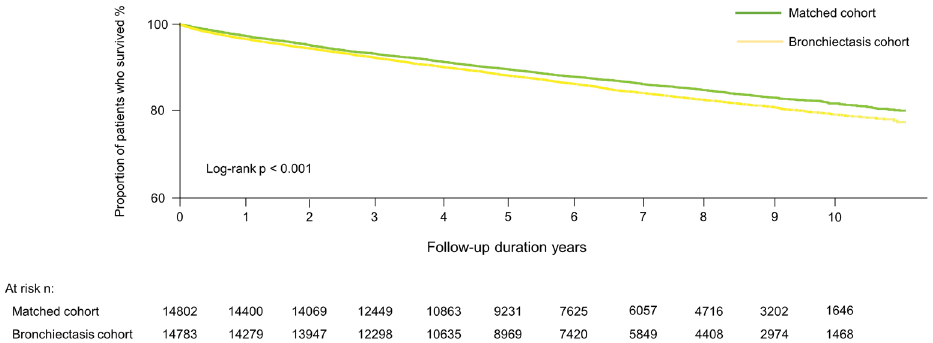
Figure 2. Kaplan–Meier survival analysis of time to death by bronchiectasis status.